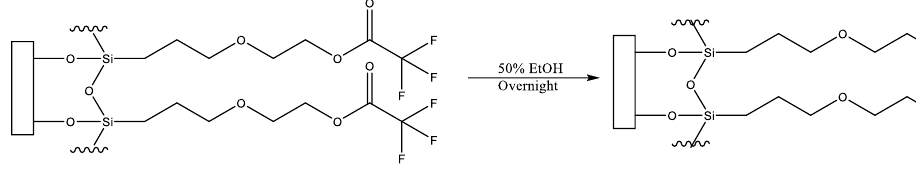
Figure 1. Conversion of surface bound MEG-TFA to MEG-OH.